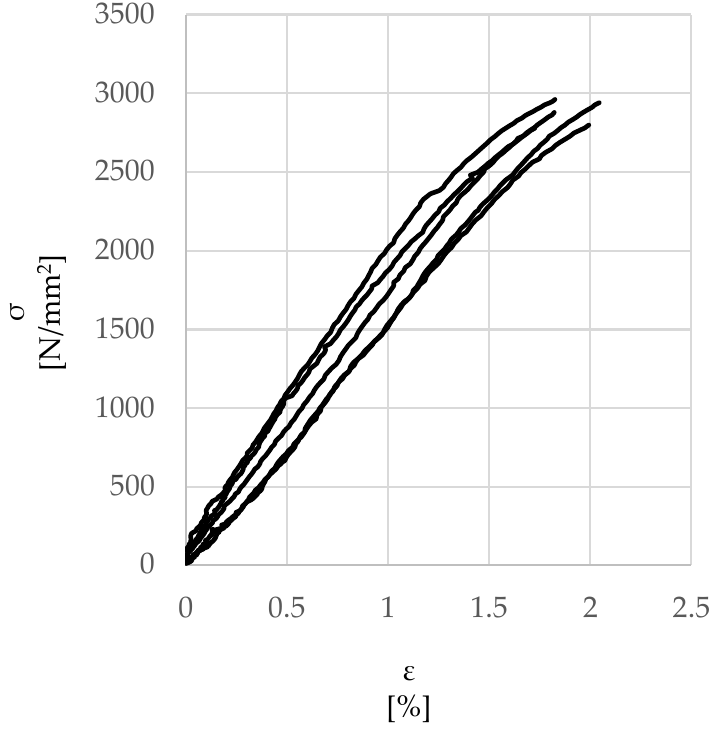
Figure 2. Stress–strain ( σ - ε ) response of UHTSS cords.